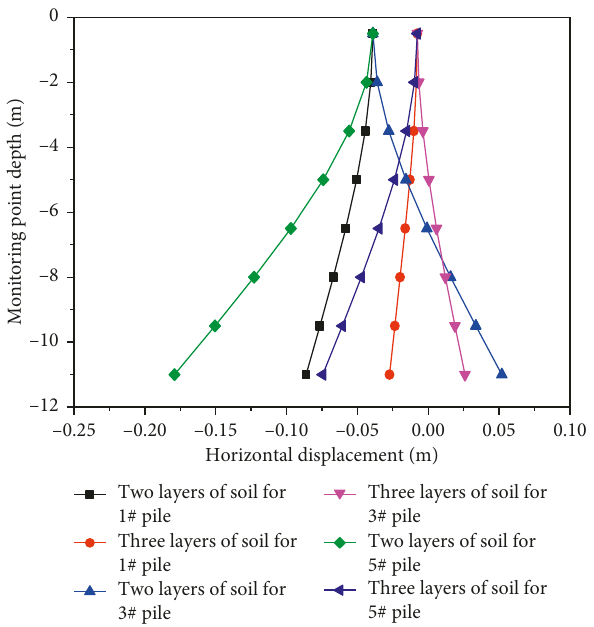
Figure 16: Comparison of the horizontal displacement for dif- ferent soil layers.